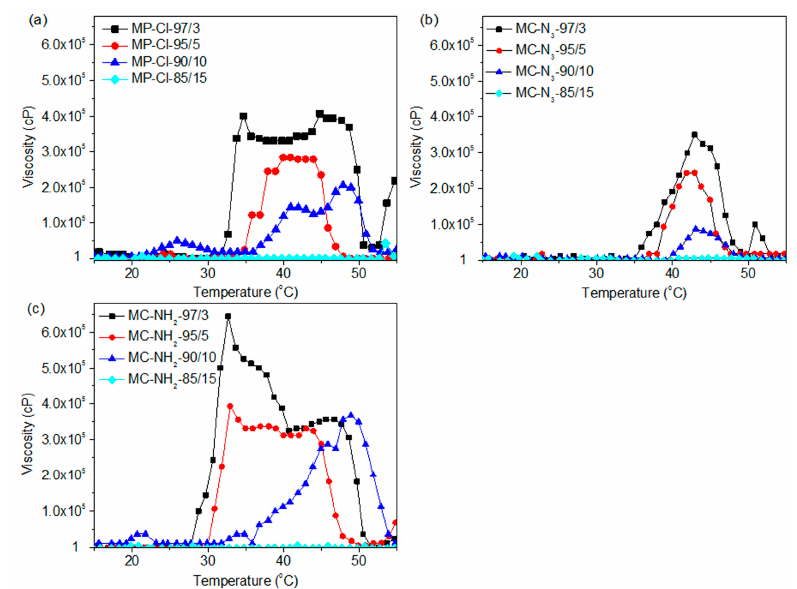
Figure 6. Viscosity-versus-temperature curves of ( a ) MP-Cl with 3–15 mol % of chloride pendant groups, ( b ) MP-N 3 with 3–15 mol % of azide pendant groups, and ( c ) MP-NH 2 with 3–15 mol % of amine pendant groups.